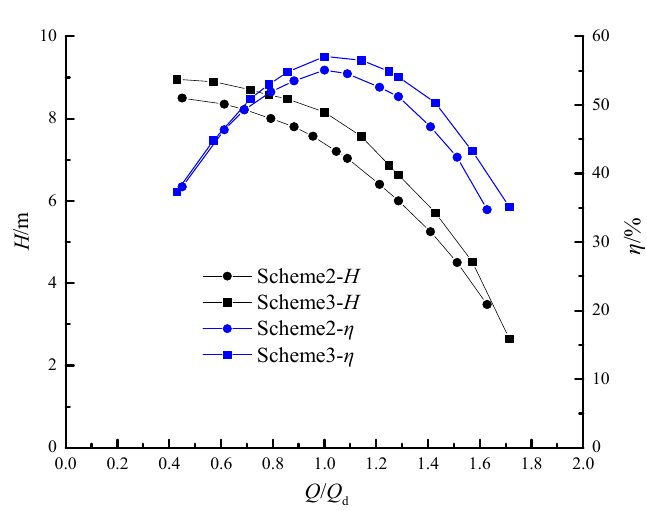
Figure 18. Comparison of external characteristic curves.